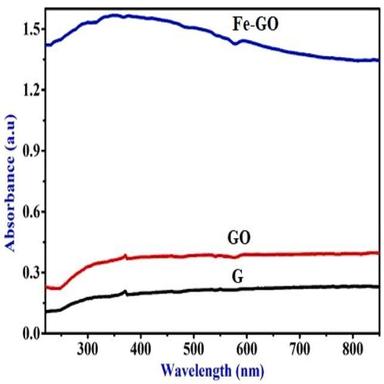
Diffuse Reflectance Spectra (DRS) for Graphite (G), Graphene Oxide (GO), and the Fe-GO Nanocomposite.